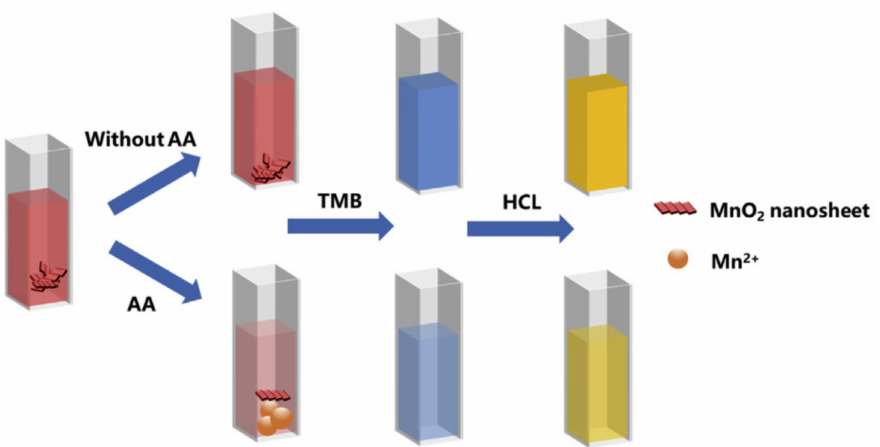
Figure 5. The schematic for ascorbic acid detection using a colorimetric assay with a TMB-MnO 2 reagent. In the reaction, the serum is injected into the Quartz cuvette, which will be located inside the device for measuring. MnO 2 is added into the serum sample, followed by the addition of TMB and HCl to shift the solution’s colour from red to blue and yellow respectively